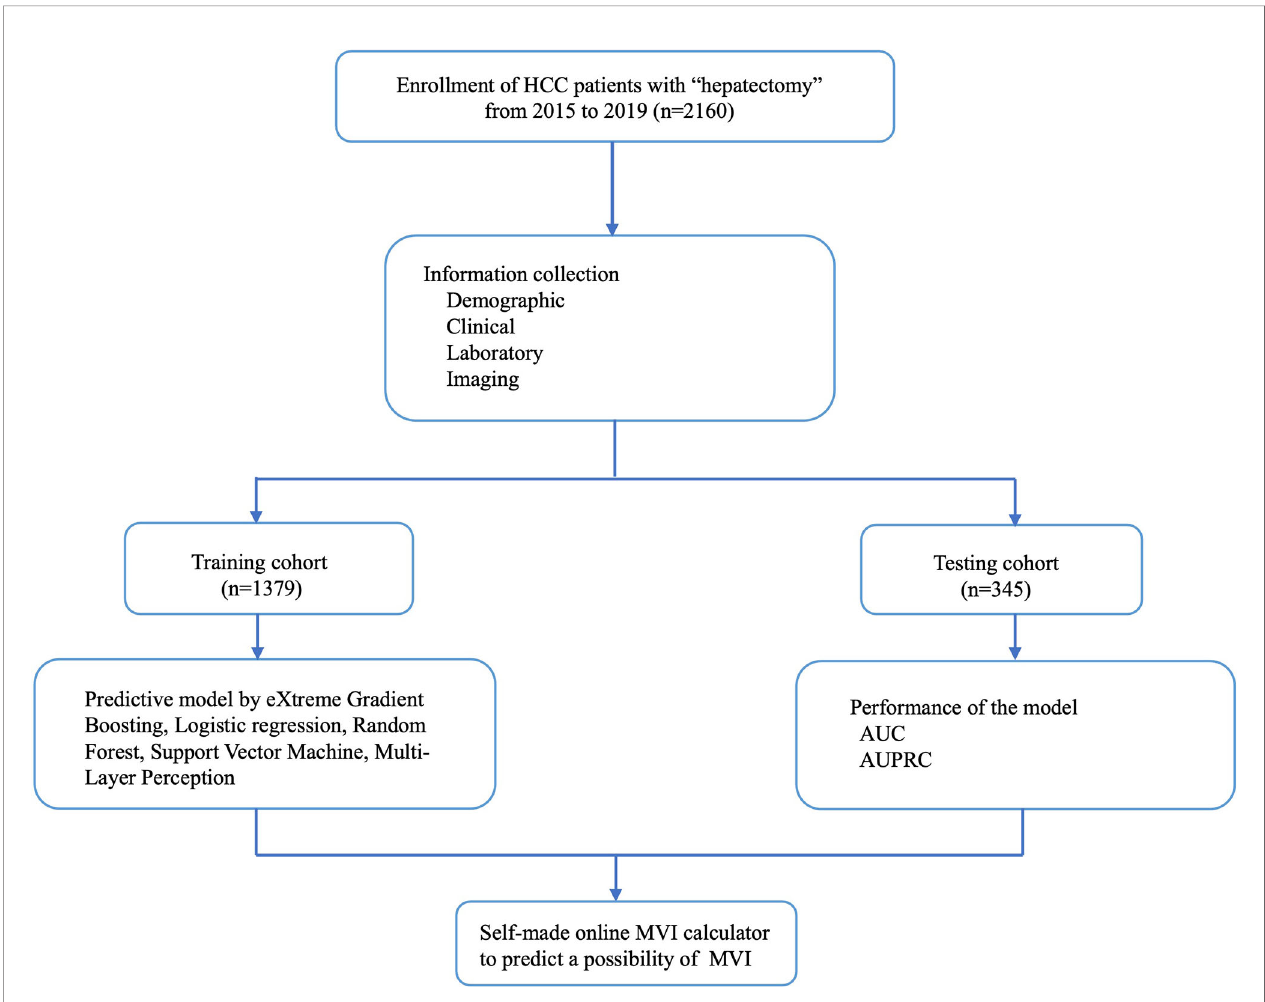
FIGURE 1 | Flow chart of patient